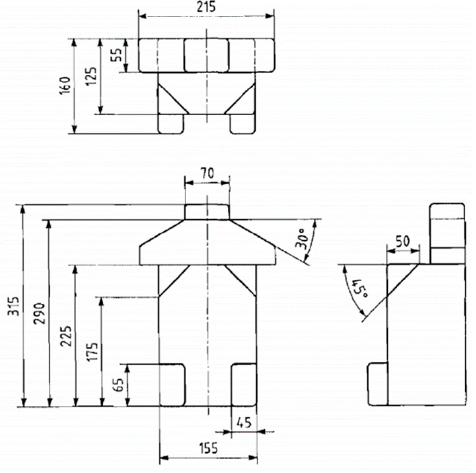
Figure 6. Test dummy with its dimensions [mm] for child seat roll-over test [40].